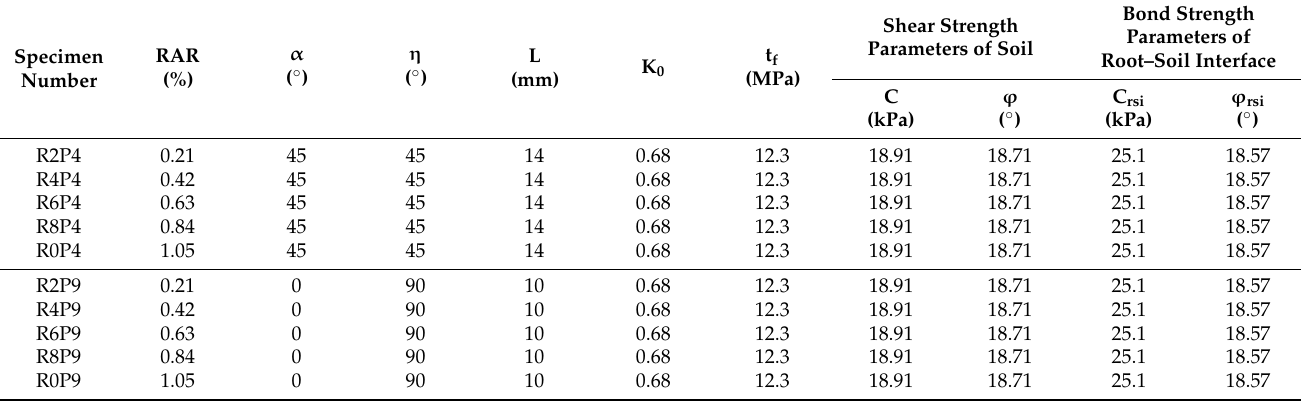
Table 8. Model calculation parameters of shear strength of root-permeated soil.